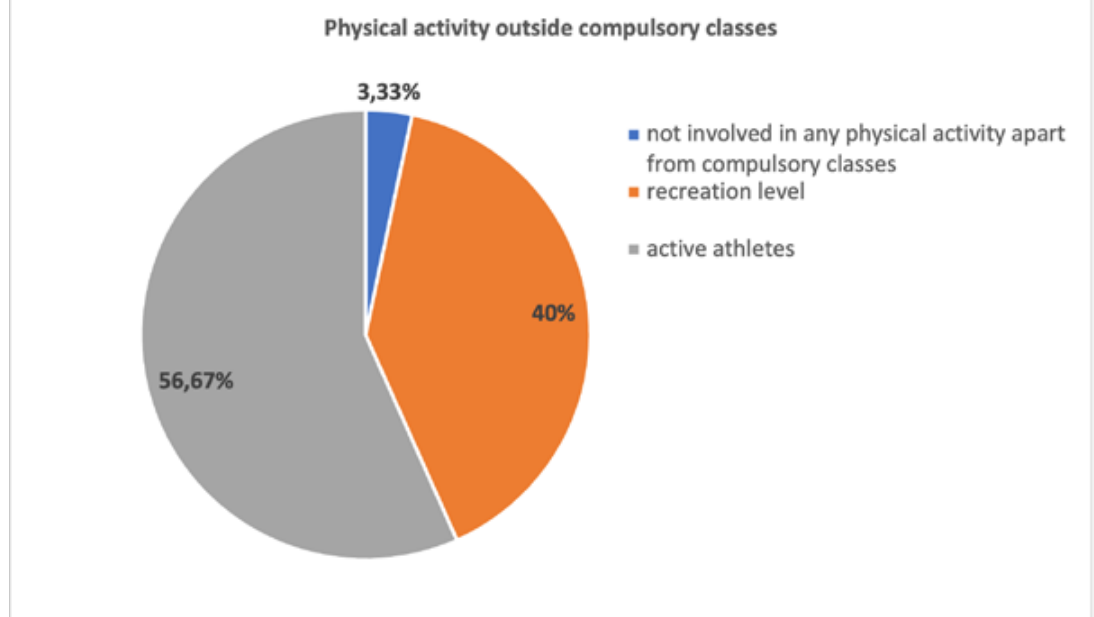
Figure 1. The nature of the physical activity practiced by the respondents outside of compulsory physical activities in their